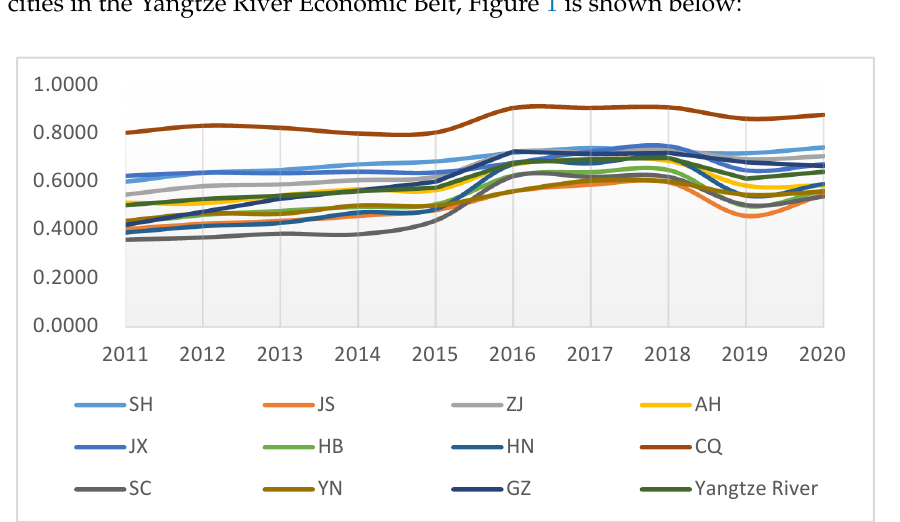
Figure 1. Ecological and environmental quality of 11 provinces and cities in the Yangtze River Economic Belt.